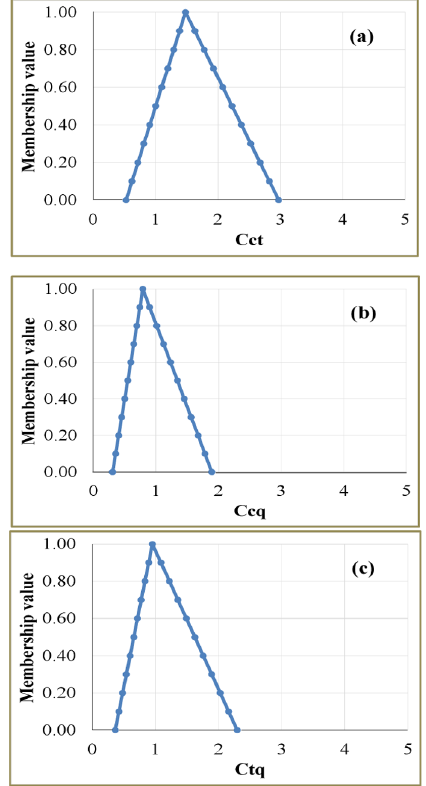
Fig. 4. Fuzzy numbers of pairwise comparisons between (a) cost vs time (C tq ); (b) cost vs quality (C cq ) and (c) time vs quality (C ct